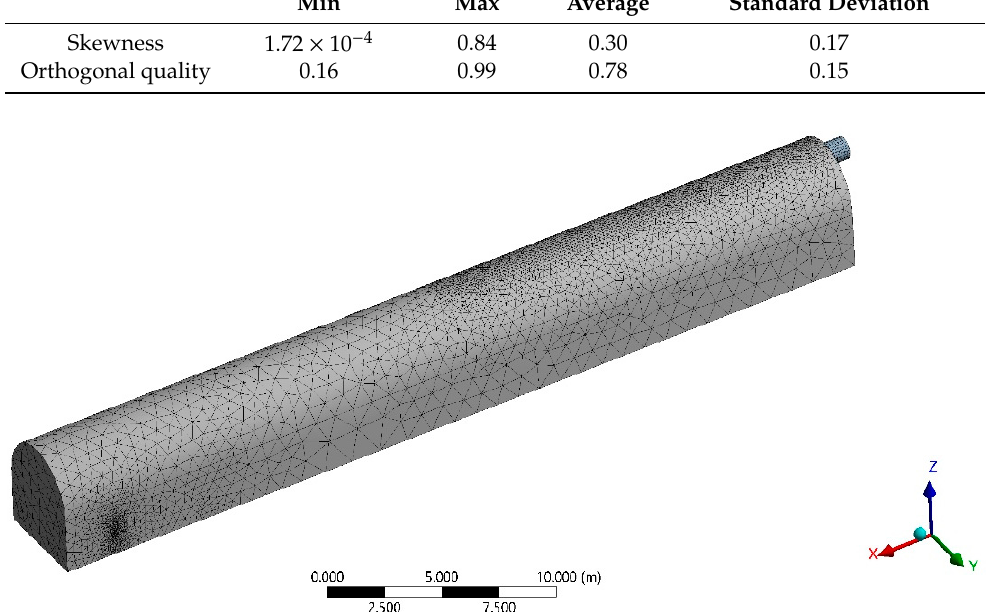
Figure 7. Geometric model ( a , b ).